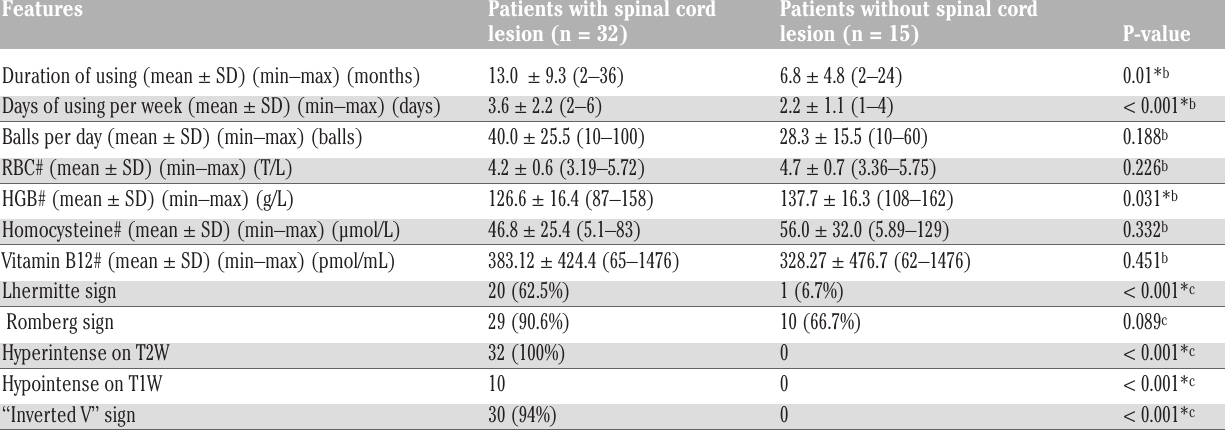
Table 3. Clinical and subclinical feature comparison between patients with and without spinal cord lesions. Features